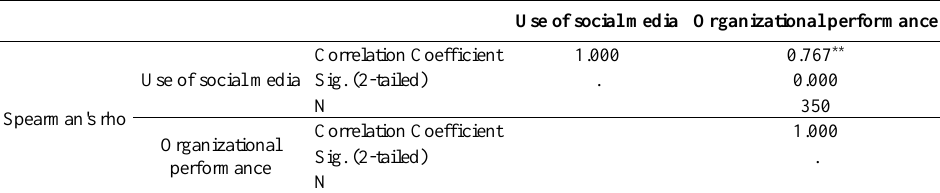
Table 7. Analyzes of